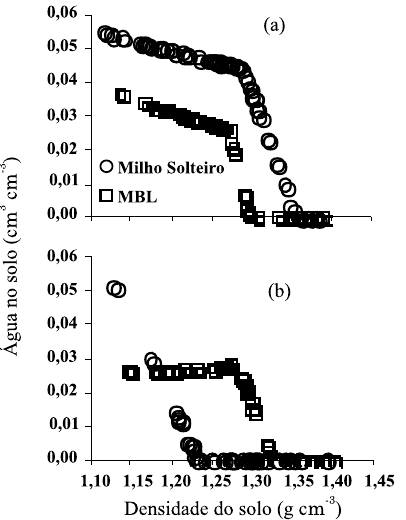
Figura 3. Resistência mecânica à penetração com umidade na capacidade de campo, nos sistemas de manejo de milho solteiro (MS) e de milho con- sorciado com braquiária na linha de semeadura (MBL). Letras iguais não diferem entre si a 5